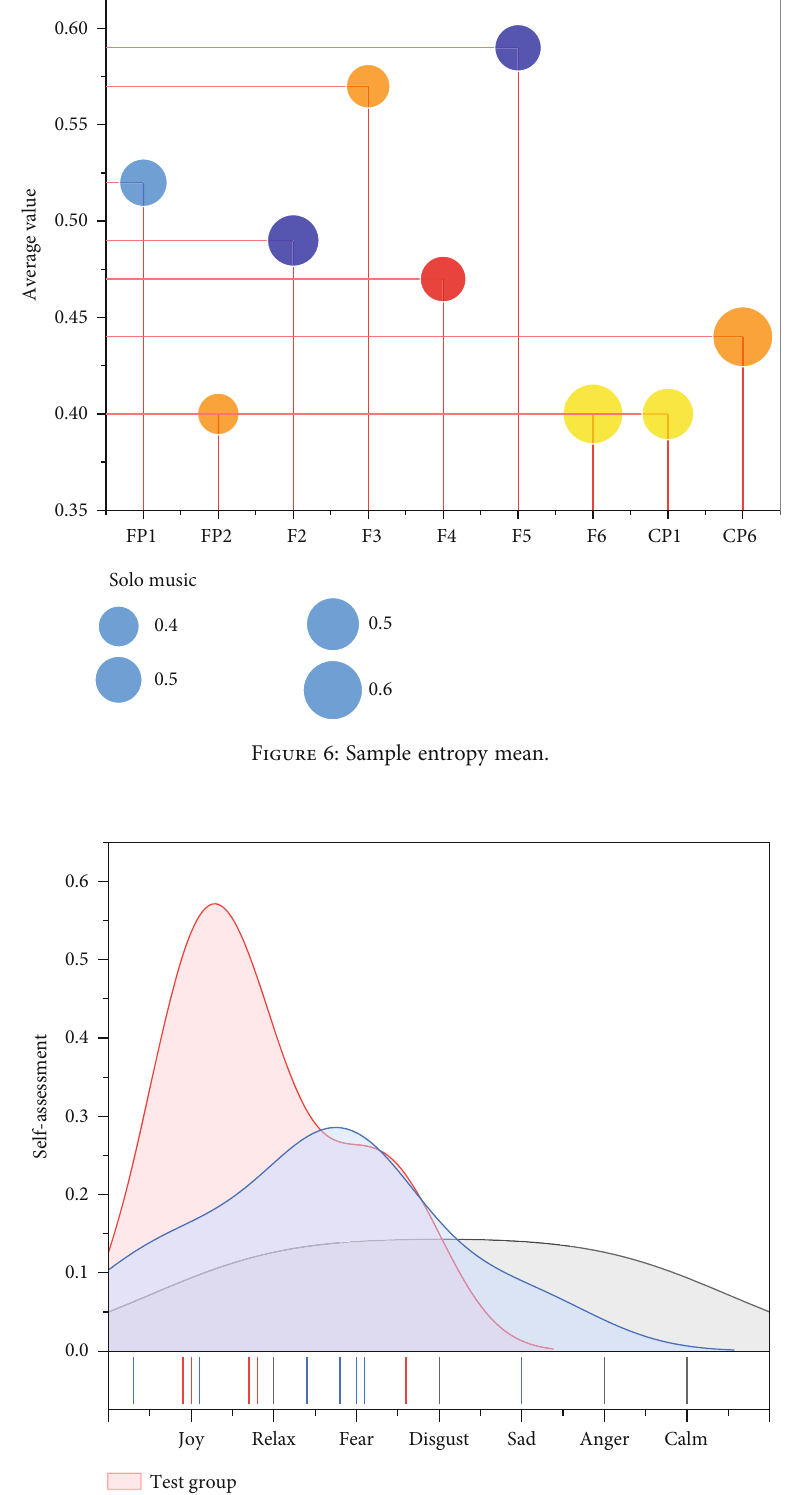
Figure 7: Comparison of results of self-assessment